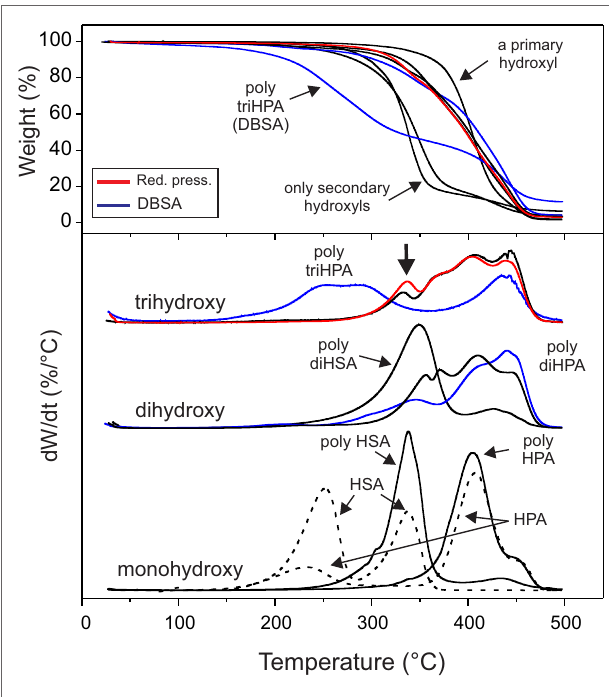
FigUre 6 | (up) Tga and (bottom) derivative curves of polyesters under n 2 flow .